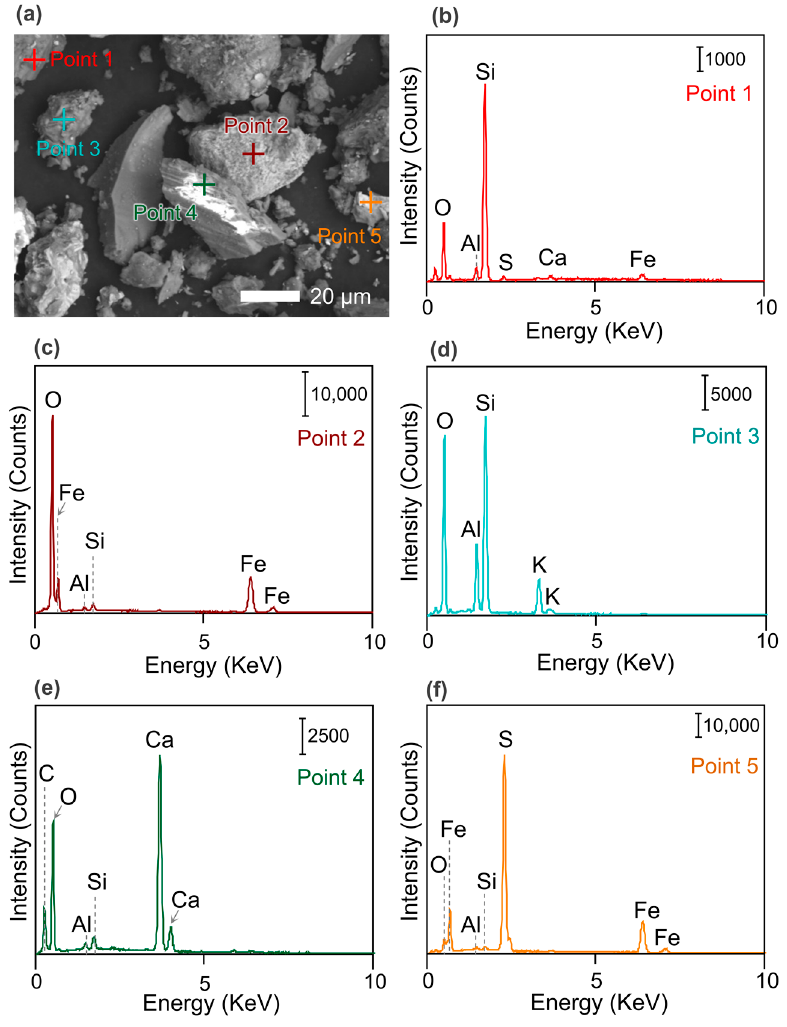
Figure 3. Photomicrograph of ASGM tailings ( a ) and the corresponding elemental point analysis of selected particles: Point 1 ( b ), Point 2 ( c ), Point 3 ( d ), Point 4 ( e ) and Point 5 ( f ). Note the differences in the scale of the y -axis of the EDS spectra.